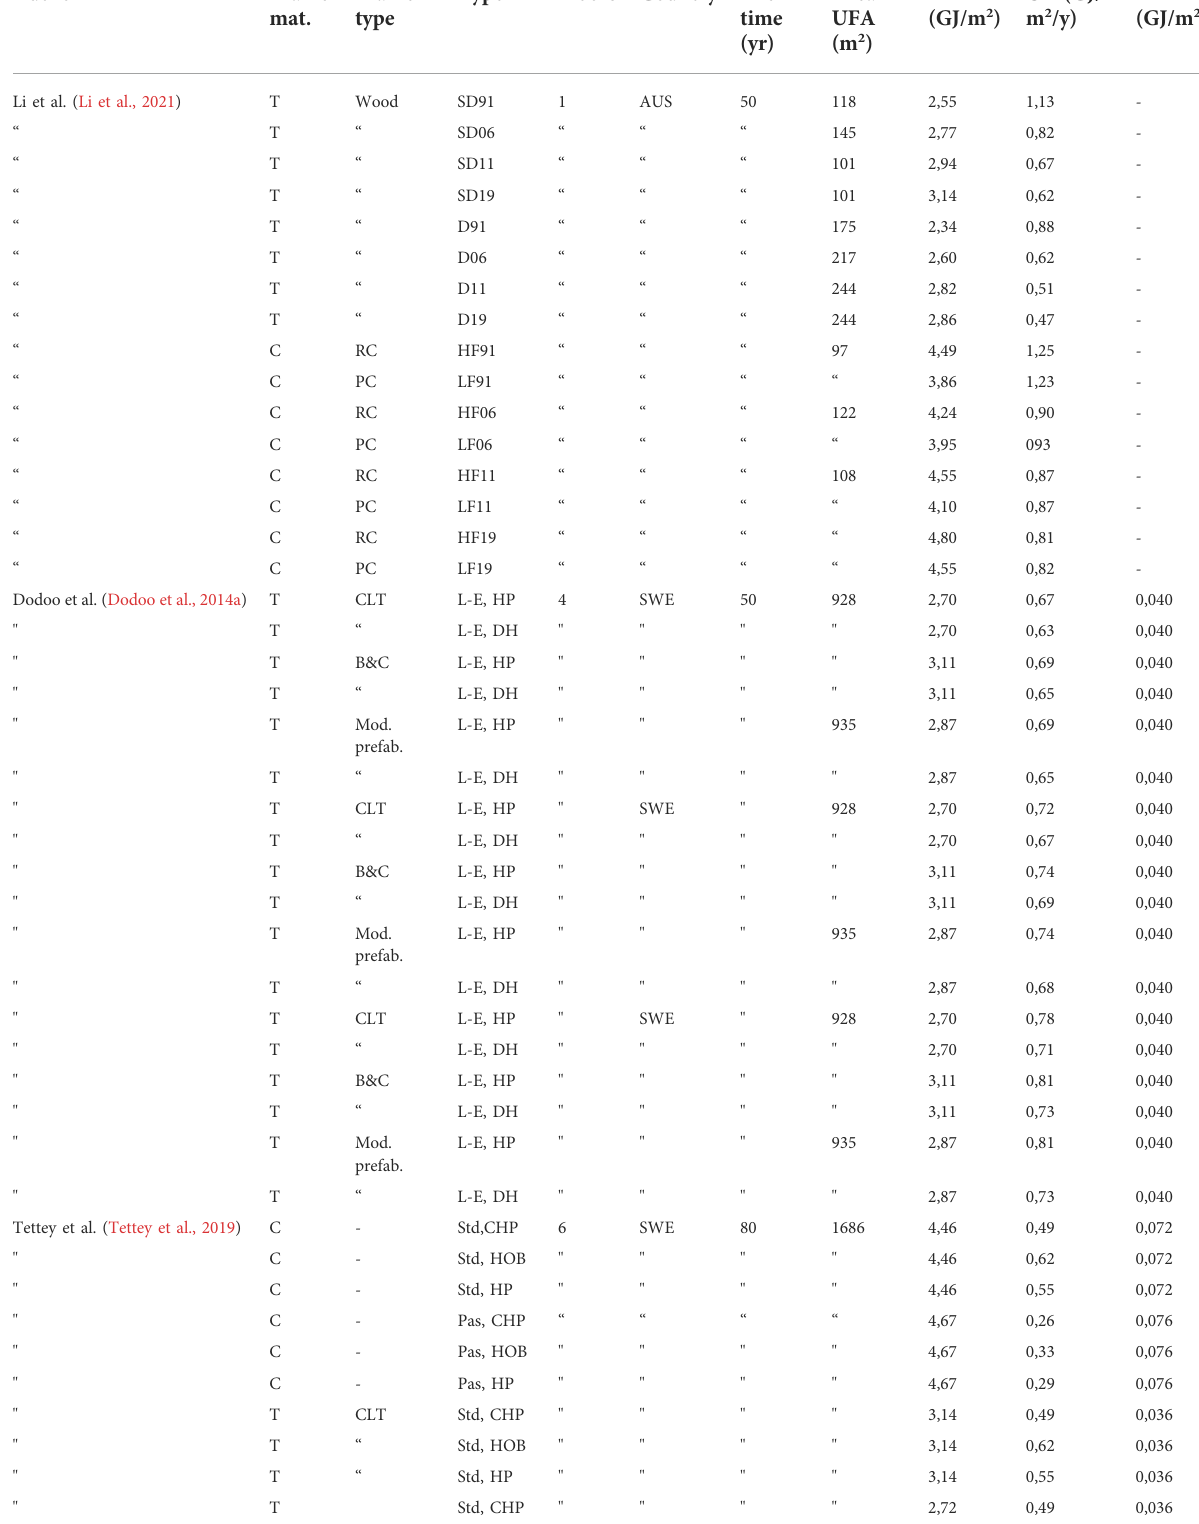
TABLE 2 Life Cycle Energy Analysis data gathered from reviewed